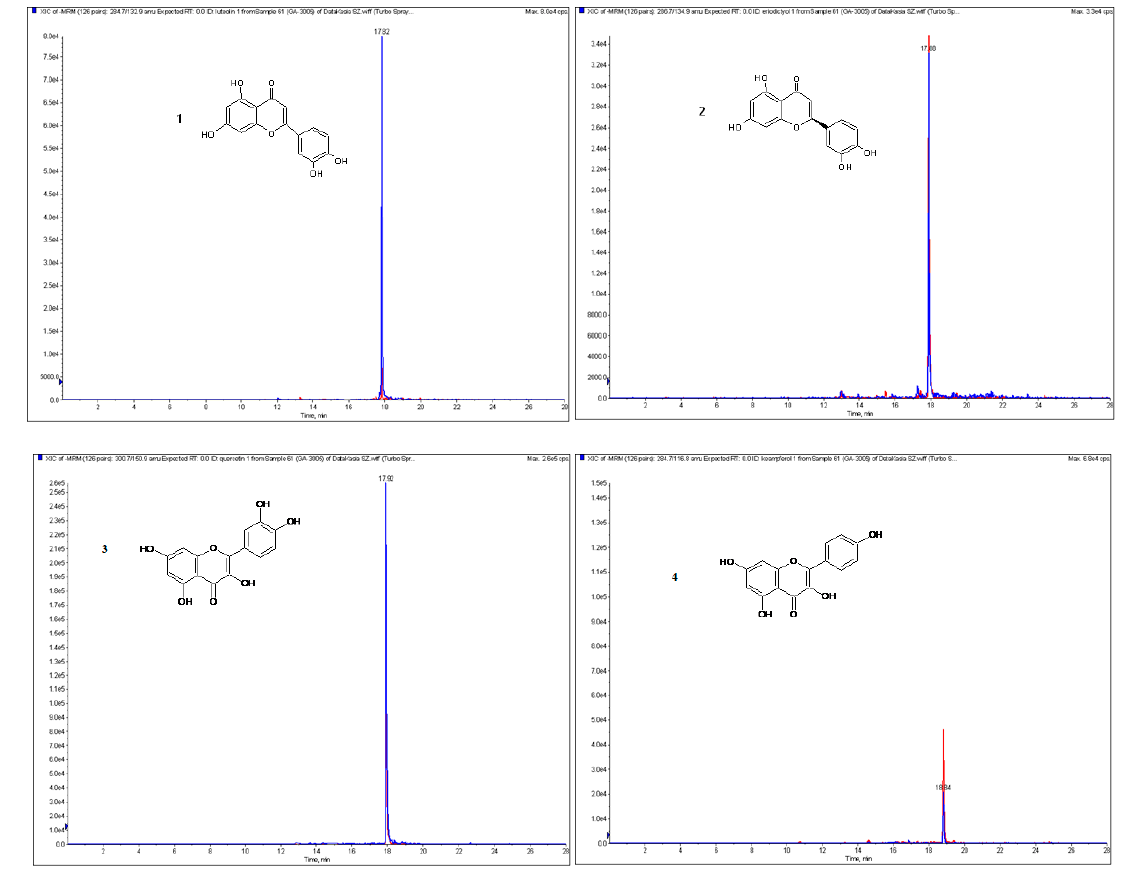
Figure 1. The chromatograms in multiple reaction mode (MRM) of flavonoid aglycones occuring in the methanolic extract of L. krapffii fruits: 1-luteolin; 2-eriodictyol; 3-quercetin; 4-kaempferol.